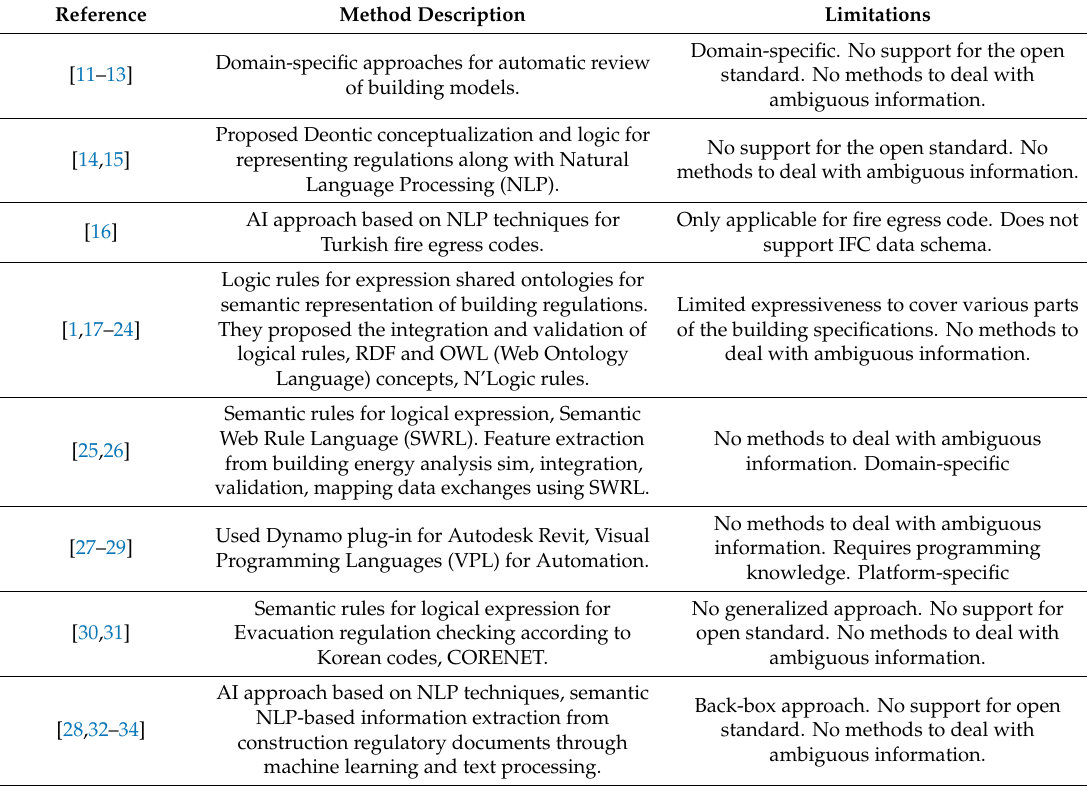
Table 1. Summary of recent studies related to automating design rules compliance